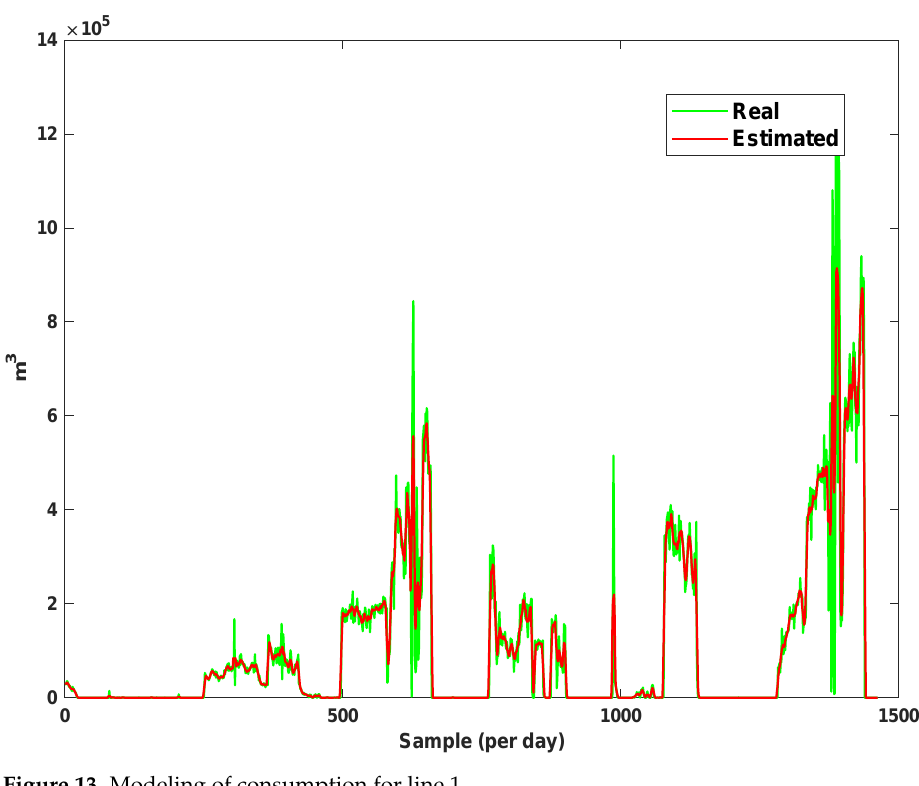
Figure 13. Modeling of consumption for line 1.